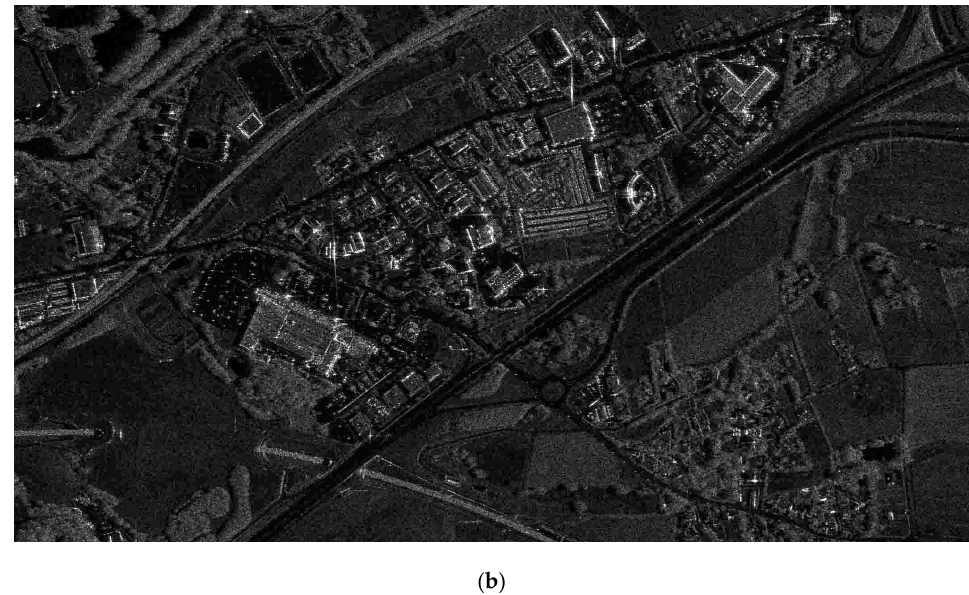
Figure 8. P-mode image of Rennes city, France. ( a ) Whole image; ( b ) Partial enlarged view of red rectangle area in ( a ).